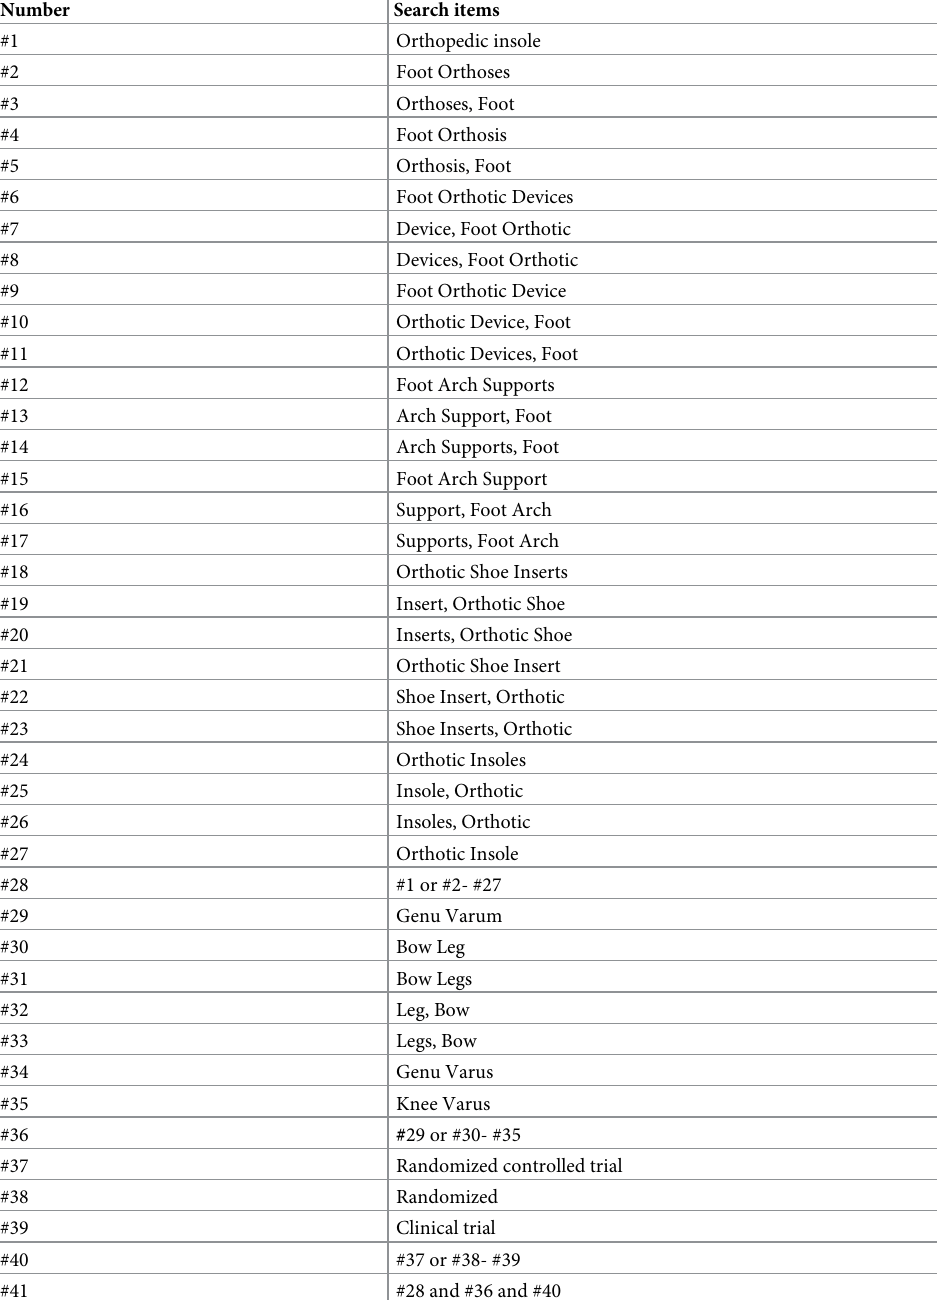
Table 1. Search strategy for the PubMed